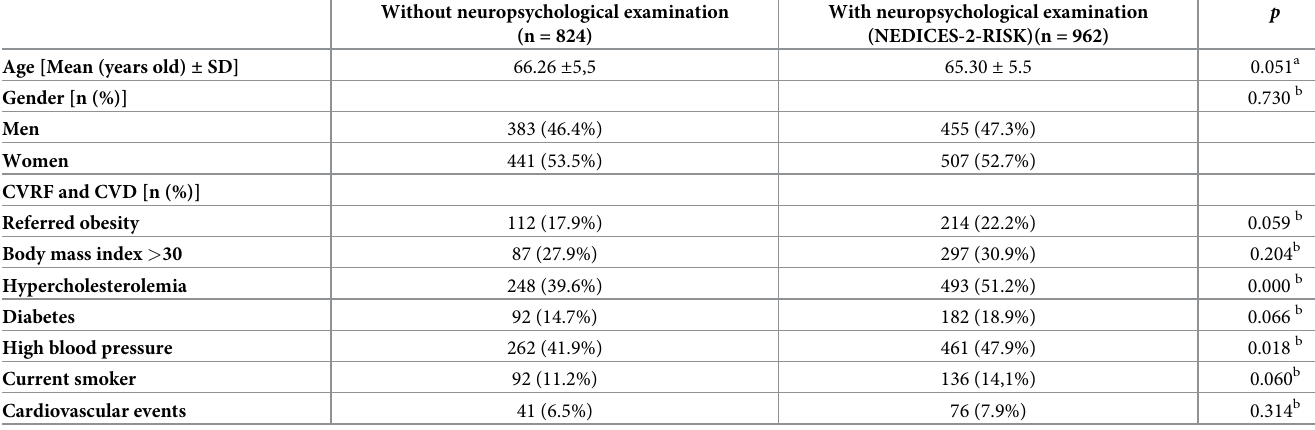
Table 2. Characteristics of the population in the study